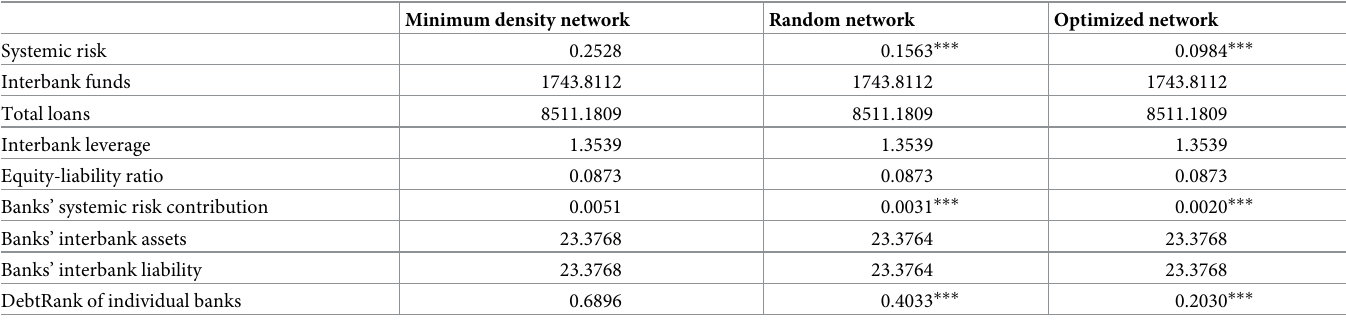
Table 3. Annually average results of various